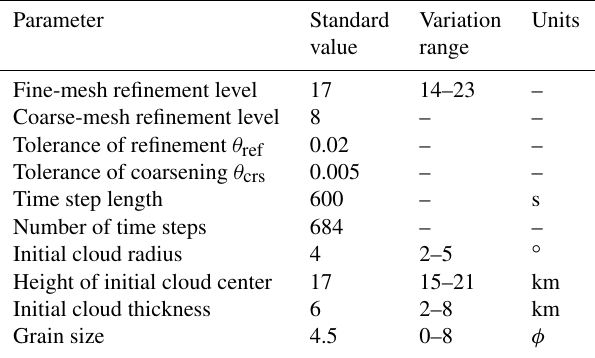
Table 2. Parameter values used in the model calculations. For θ ref ,θ crs , see Eqs. (4) and (6).